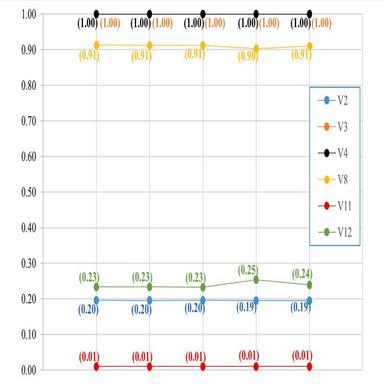
Normalized values of the calibration parameters for the different genetic algorithm runs.